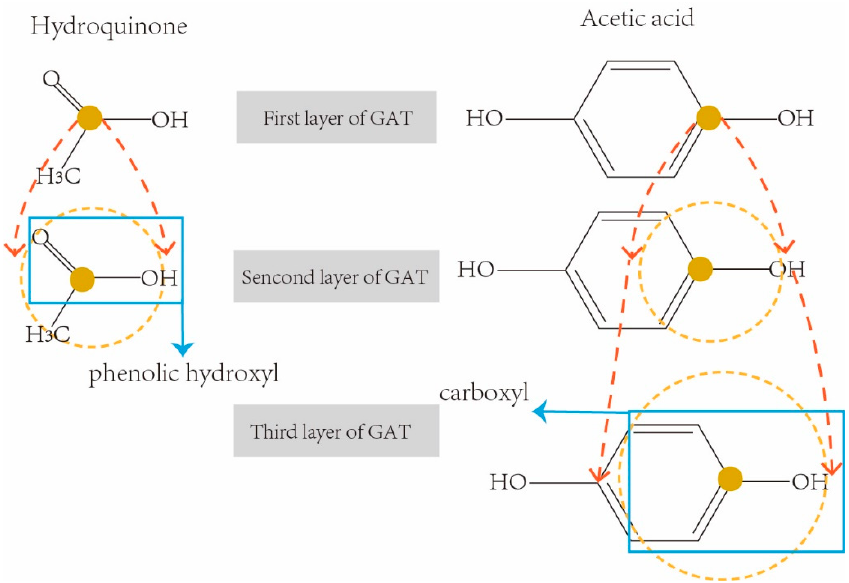
Figure 4. Examples of receptive fields with k -hop convolution network.